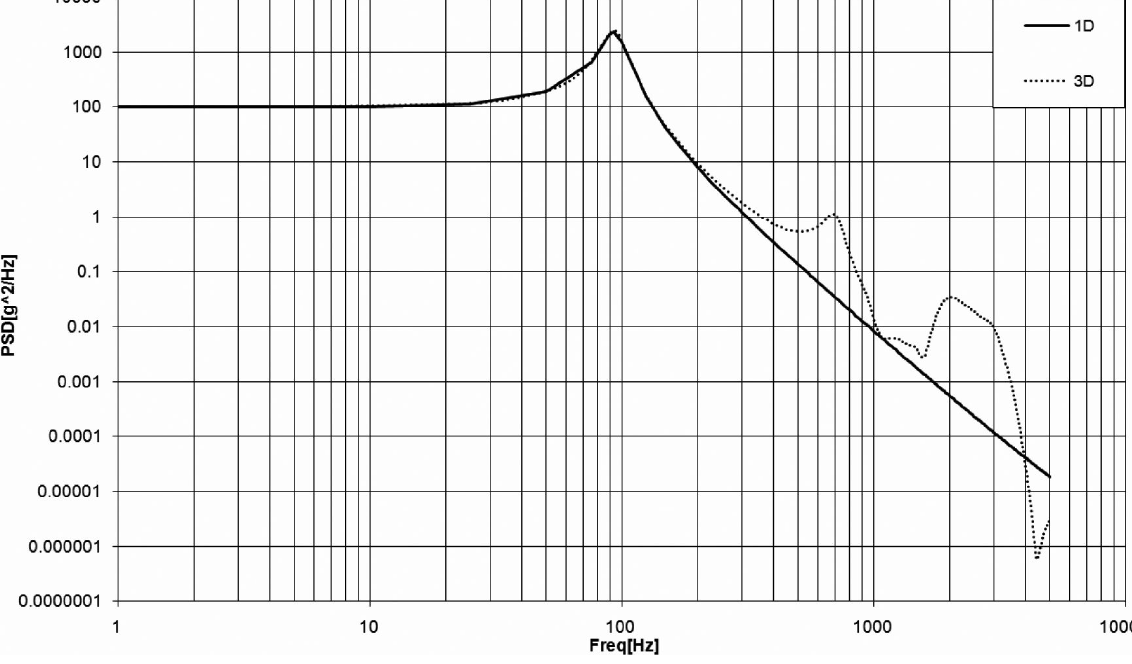
Fig. 10. Frequency response curves of a 1D TDA (dotted) and 3D TDA